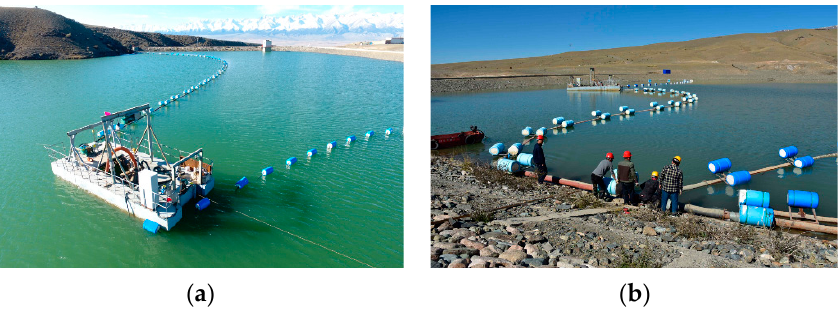
Figure 1 . Field test of self-priming pipe sand removal technology. ( a ) Field test of reservoir desilting, ( b ) Desilting pipe.